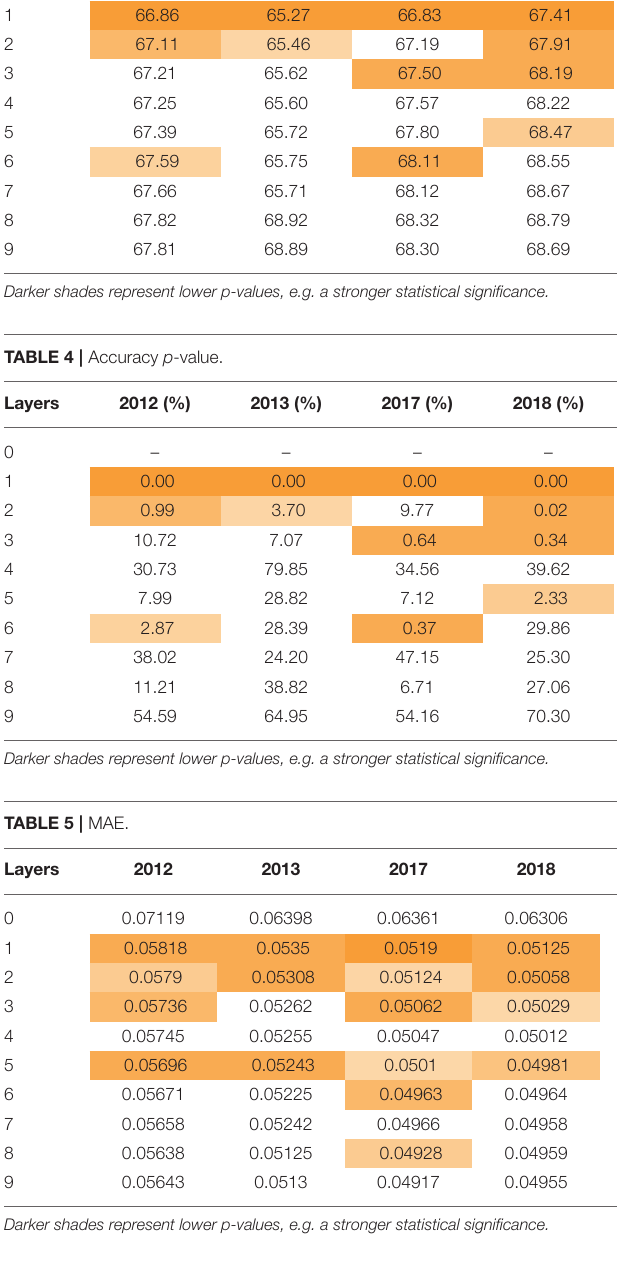
TABLE 3 | Accuracy. Layers